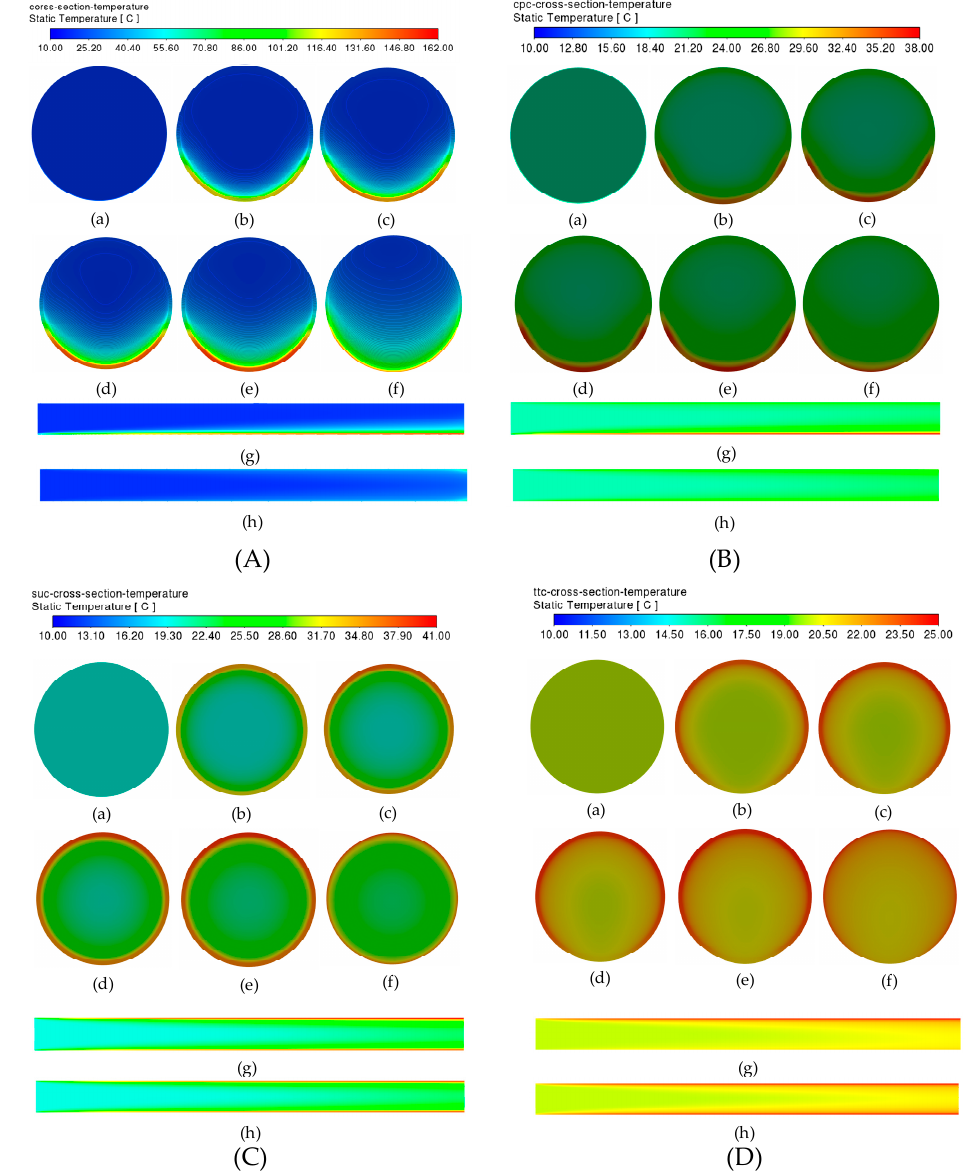
Figure 13. The cross-section temperature distributions of ( A ) the PTC, ( B ) the CPC, ( C ) the SUC and ( D ) the TTC in the SWH systems at ( a ) P1, ( b ) P2, ( c ) P3, ( d ) P4, ( e ) P5, ( f ) P6, ( g ) central cross-section along the absorber in x-y (vertical) plane, and ( h ) central cross-section along the absorber in x-z (horizontal) plane.